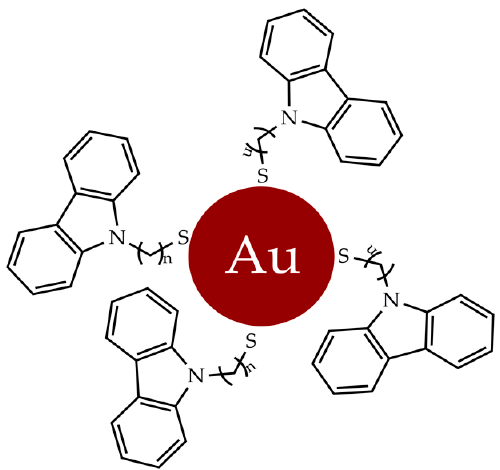
Figure 2. Gold nanoparticles functionalized with N -thioalkylcarbazole derivatives.